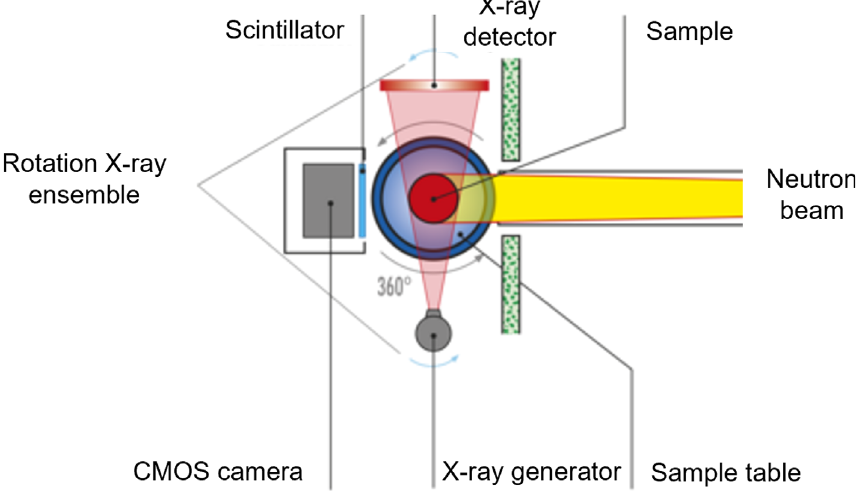
Fig. A1. Schematized top view of the NeXT dual modality lines (modi fi ed from